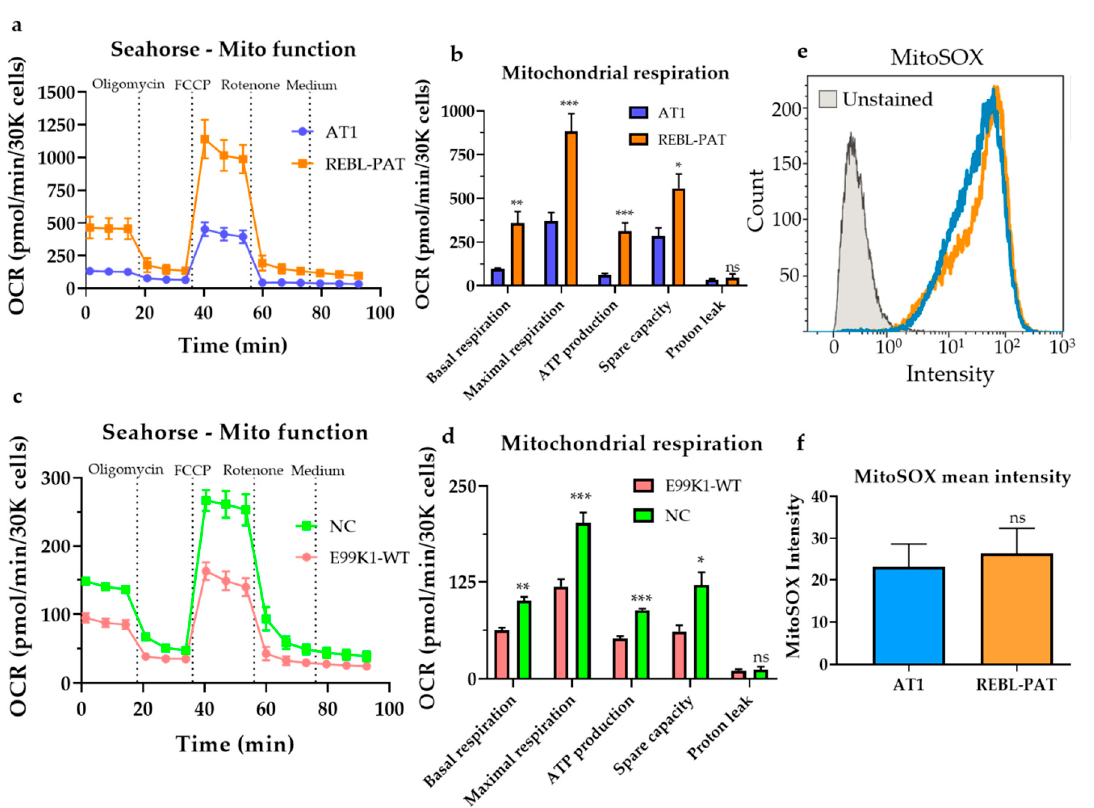
Figure 4. Mito-modulating effects of mtDNA variants identified in hPSC-CMs. ( a ) Mitochondrial respiration was evaluated by Seahorse analysis of healthy hPSC-CM lines used to model the p.R453C- β MHC sarcomeric mutation, showing ( b ) higher oxidative phosphorylation activity in REBL-PAT cardiomyocytes relative to the AT1 line, presenting different mtDNA variants. ( c , d ) The healthy (gene-corrected) E99K1-WT hPSC-CM line showed lower mitochondrial respiration activity relative to NC hPSC-CMs displaying diverse mtDNA variants. ( e , f ) Evaluation of mitochondrial ROS production by flow cytometry of MitoSOX-labelled hPSC-CMs showed no difference between healthy AT1 vs REBL-PAT hPSC-CMs, indicating that the mtDNA variants identified in these lines do not contribute to mito-dysfunction. Data are presented as mean ± SEM, N = 5-7 biological replicates, * p < 0.05, ** p < 0.01, *** p < 0.001, n.s., non-significant (Student’s t -test); OCR, oxygen consumption rate.